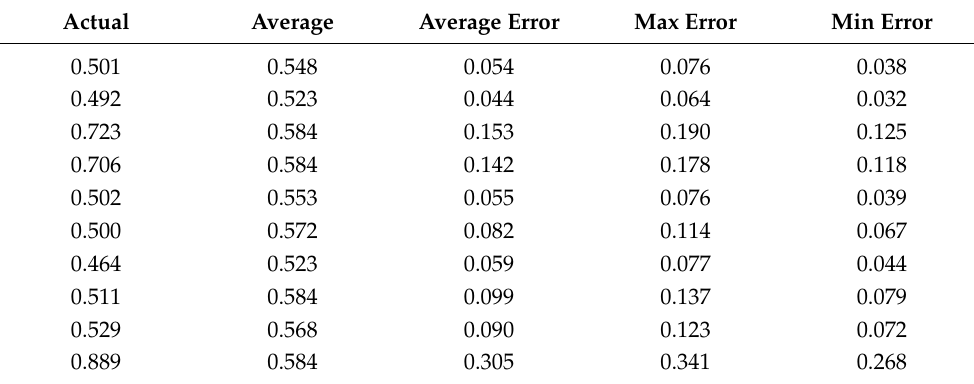
Table A2. Set 1, trials 1–10 data (actual PR value).